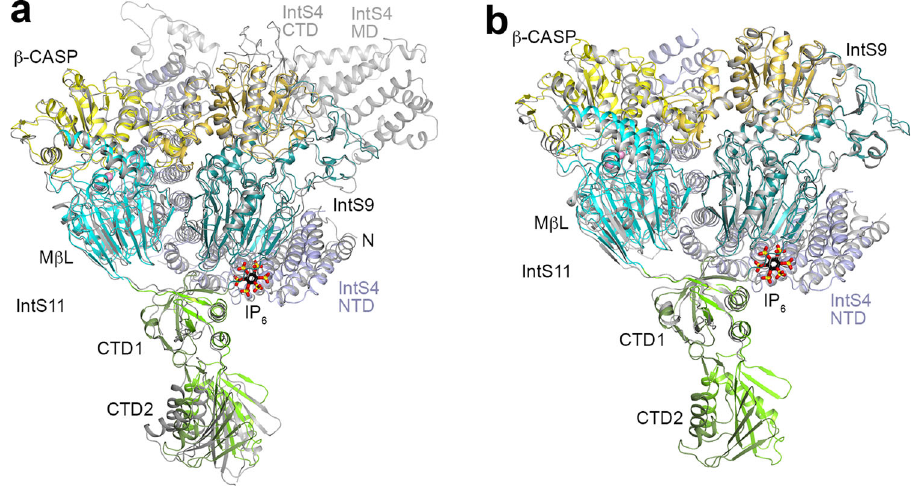
Fig.3|Structuralcomparisonbetween Drosophila andhumanICM.a Overlayof the overall structure of Drosophila ICM and human ICM in the structure of Inte- gratorincomplexwithPP2A(PDBentry7CUN).ThepositionsofCTD2ofIntS9and IntS11 are noticeably different, likely related to the fl exibility in these domains.